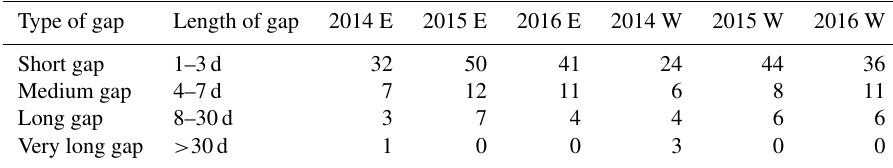
Table 3. Gaps distribution over years and wind direction.